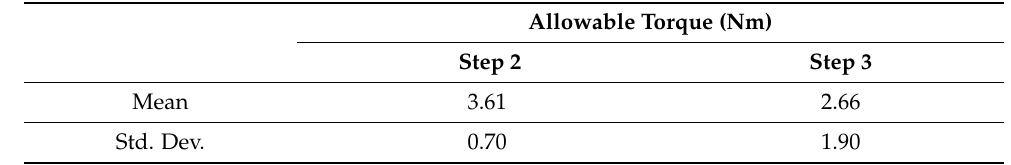
Table 5. Statistical analysis of variation in the difference of allowable torque on the rear wheel during controlled and uncontrolled conditions and with respect to change in the height of the step.